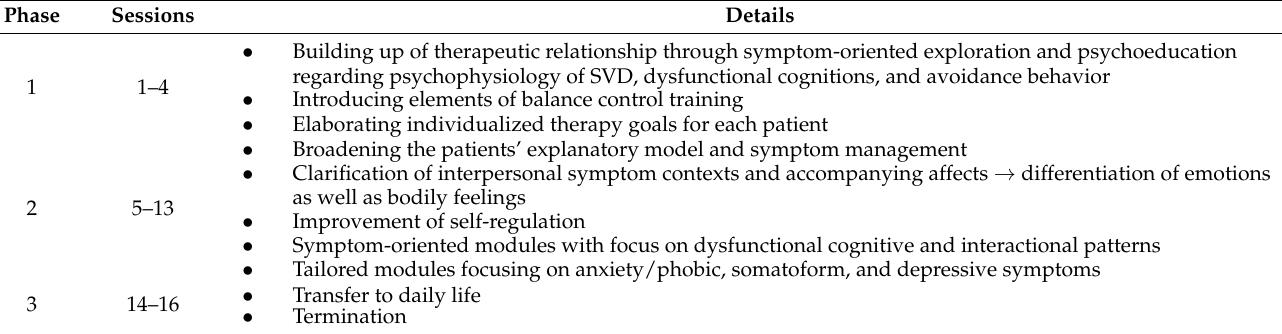
Table 2. Overview of IPGT treatment phases and